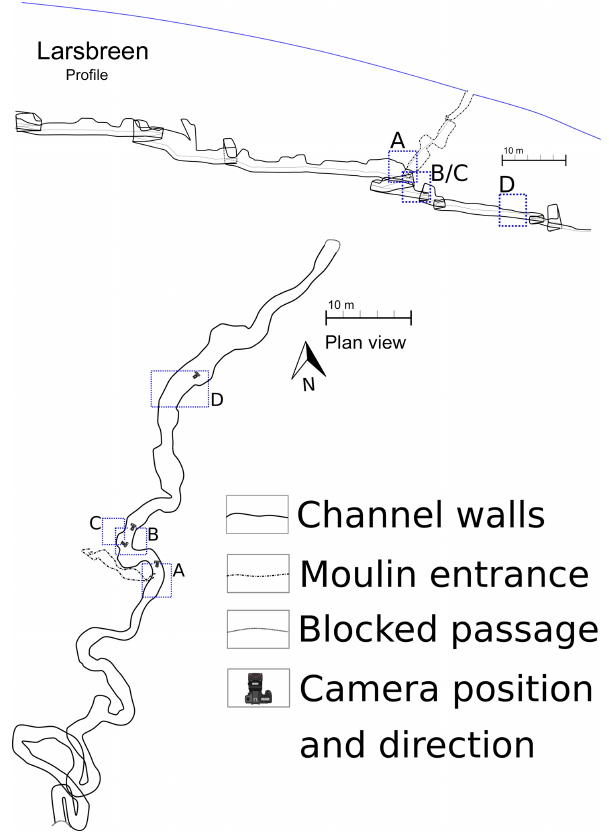
Figure 2. Plan view drainage system map of Larsbreen with picture locations (lower sketch) and profile (upper sketch) with approxi- mate glacier surface and picture locations. All pictures can be found in Fig. 4.